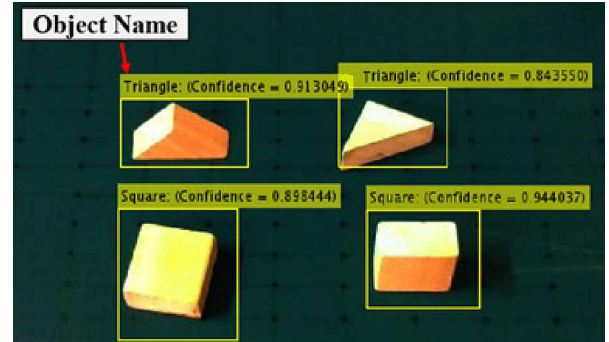
Figure 10. Training results.